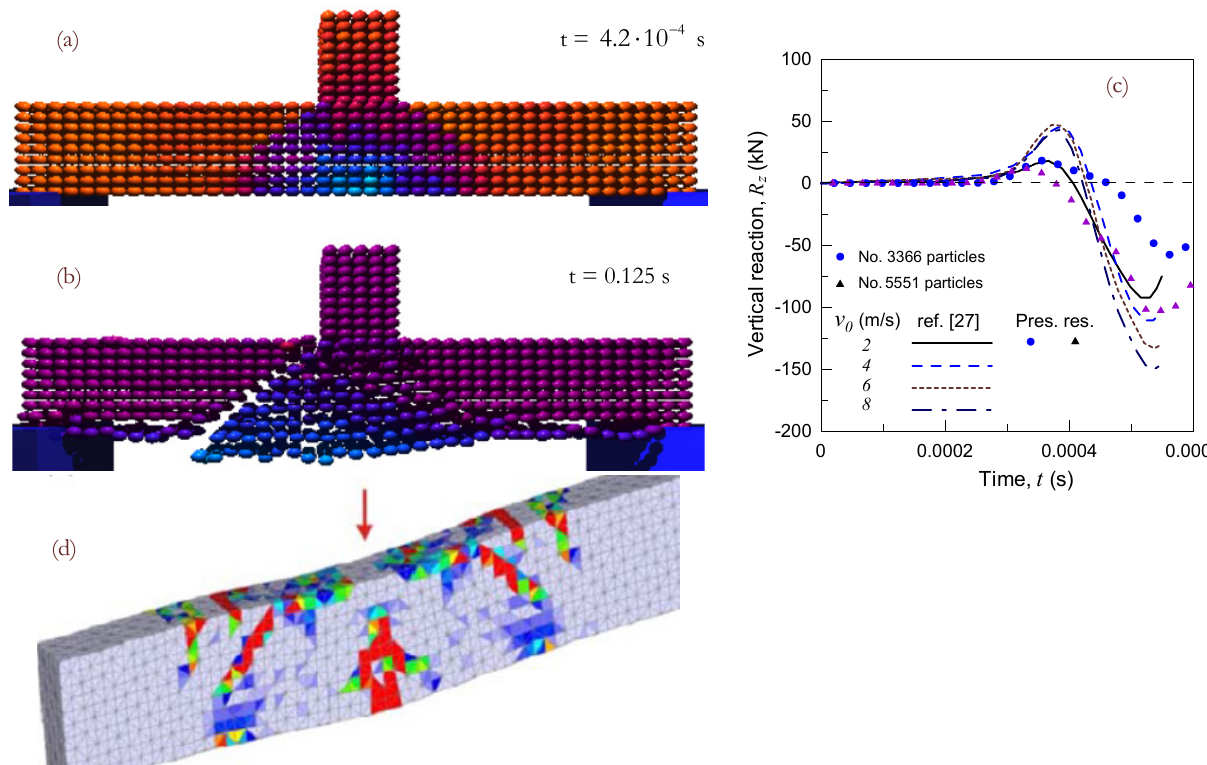
Figure 5: (a) Elastic wave propagation and (b) failure pattern for the case beginning of the impact phenomenon for